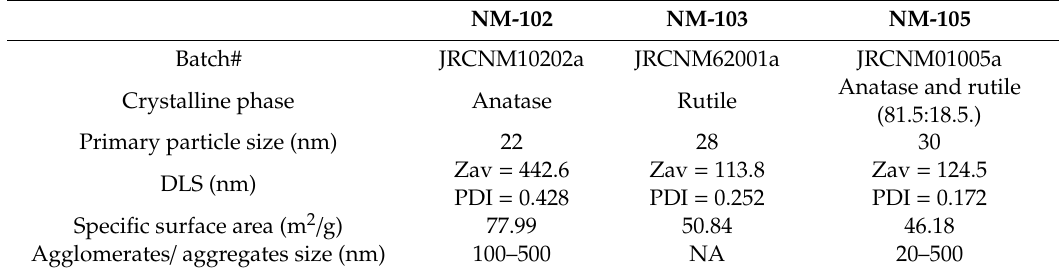
Table 1. The physicochemical characteristics of the titanium dioxide nanomaterials